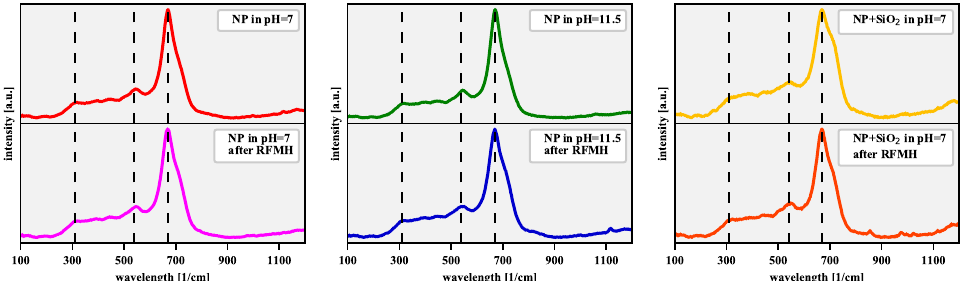
Figure 4. The Raman spectra with a substracted linear background before and after the 1800-s RFMH process for freshly prepared NPs: (left panel) bare in solution at pH = 7, (middle panel) bare in solution at pH = 11.5, and (right panel) silica-coated in solution at pH = 7. The vertical dashed lines mark the positions of the Raman spectra peaks most characteristic of